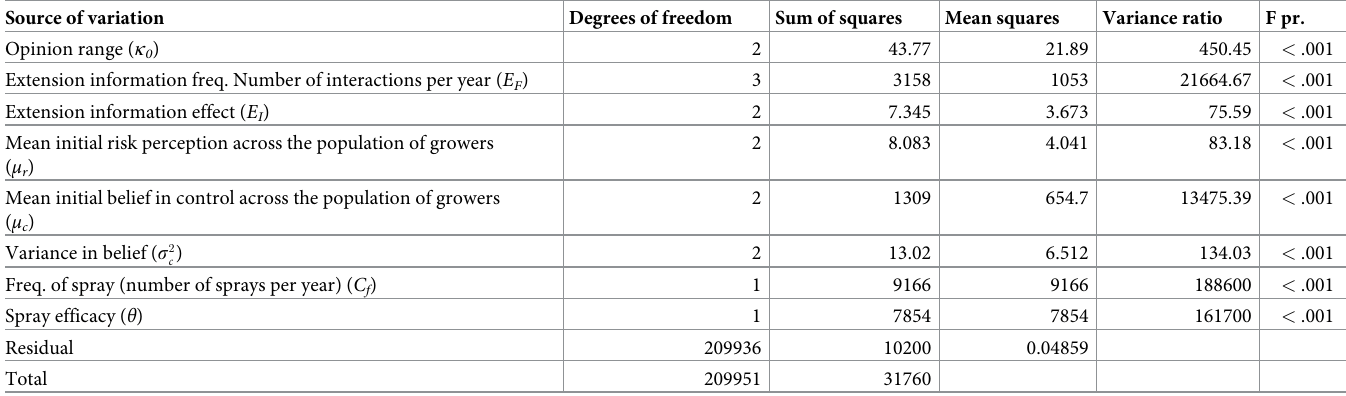
Table 3. The ANOVA table reporting main effects